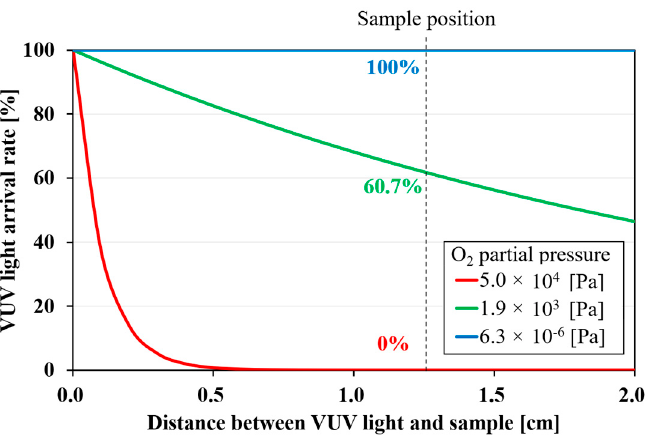
Figure A1. Calculation results of vacuum ultraviolet (172-nm) light arrival rate.